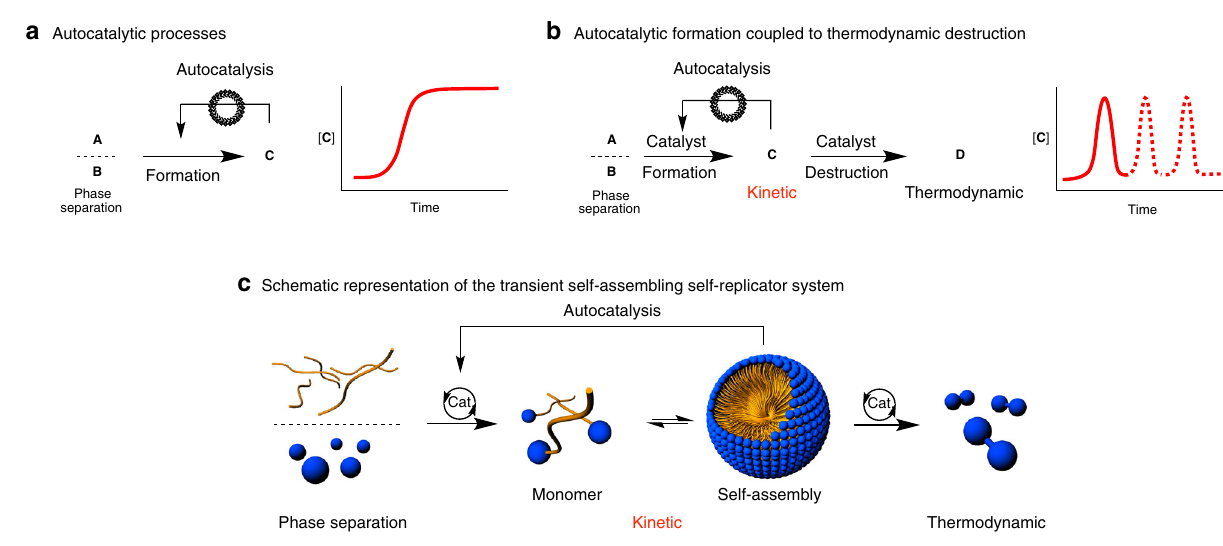
Fig. 1 Examples of autocatalysis. a An autocatalytic system based on phase separation. b An autocatalytic system based on phase separation, coupled to thermodynamic destruction, that in a closed set-up experiment will evolve towards thermodynamic equilibrium. c Schematic representation of a transient self-assembling self-replicator